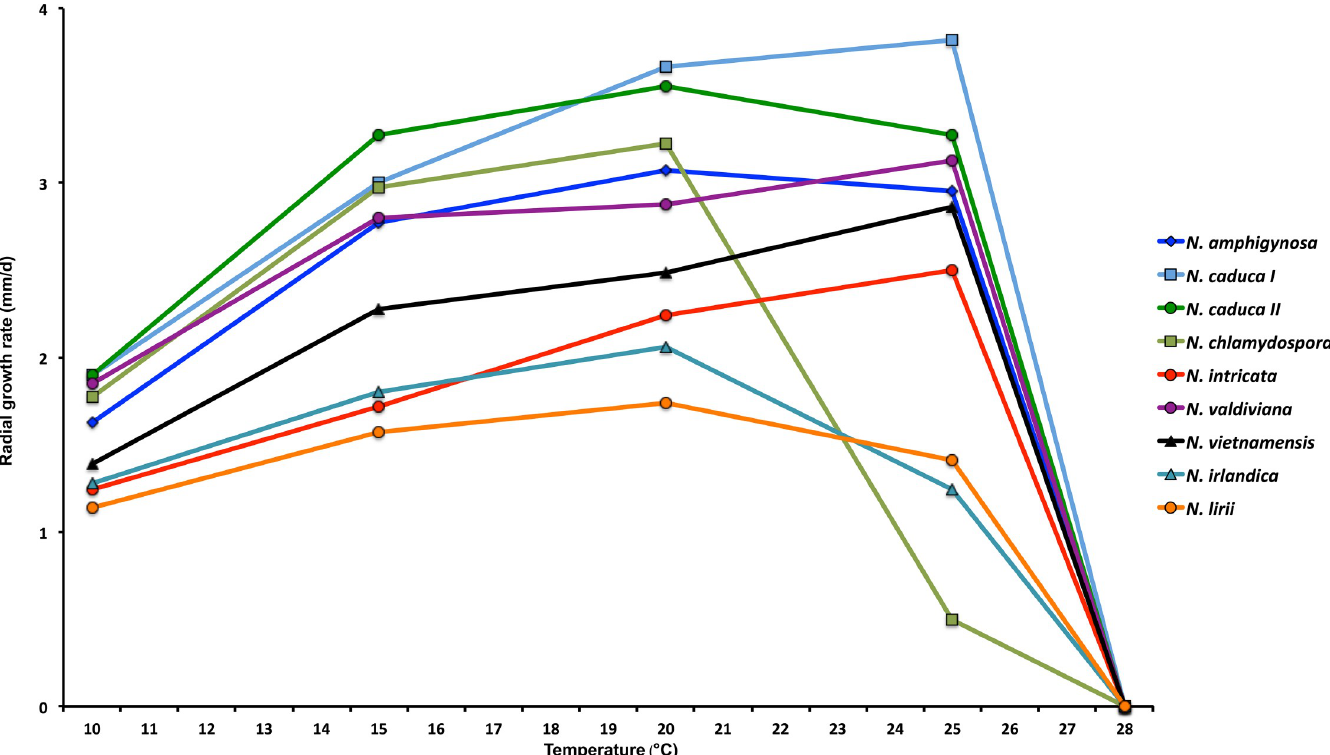
Fig 6. Mean radial growth rates on V8 agar at different temperatures for Nothophytophthora irlandica (5 isolates) and N . lirii (9 isolates) from this study in comparison to N . amphigynosa , N . caduca , N . chlamydospora , N . intricata , N . valdiviana and N . vietnamensis (data from Jung et al . 2017a [1]).